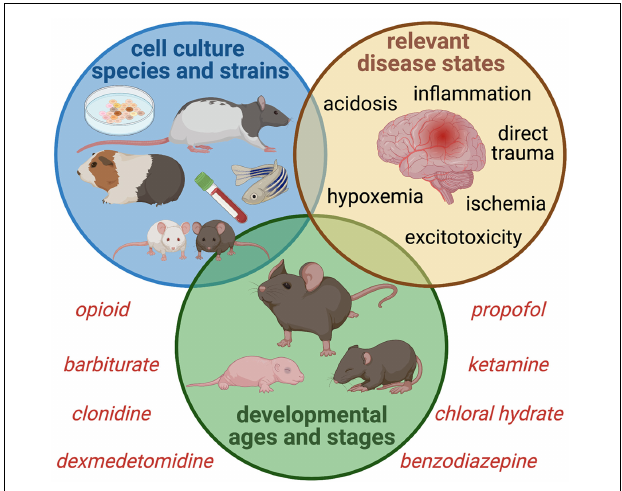
FIGURE 4 | Proposed Experimental Paradigms for Intensive Care Sedation and Neurologic Sequelae. Studies of sedative and analgesic use during critical illness must account for the complex interaction between drug altered neurotransmission and a wide variety of disease states that alter normal neurophysiology, ranging from primary brain injury to neurologic stressors such as hypoperfusion and inflammation. Sex and age-dependent vulnerability must be considered, as well as a variety of phenotypes to ensure generalizability of findings. Incorporating clinically relevant biomarkers bolsters translational value as